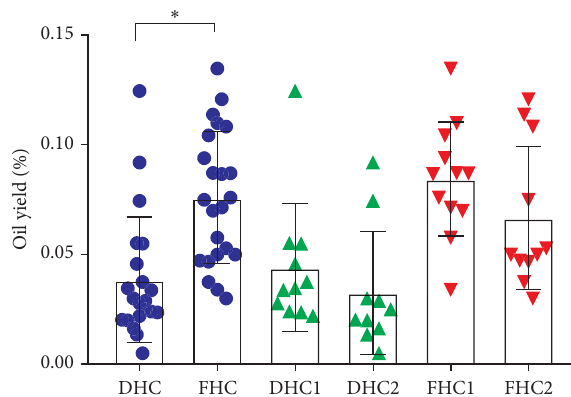
Figure 1: The EO yields (%, v/w) of twenty-one batches of DHC and twenty-three batches of FHC and their two harvest seasons (DHC1 and DHC2; FHC1 and FHC2). Data were presented as mean ± SD. ∗ p < 0 . 05, DHC compared with FHC.